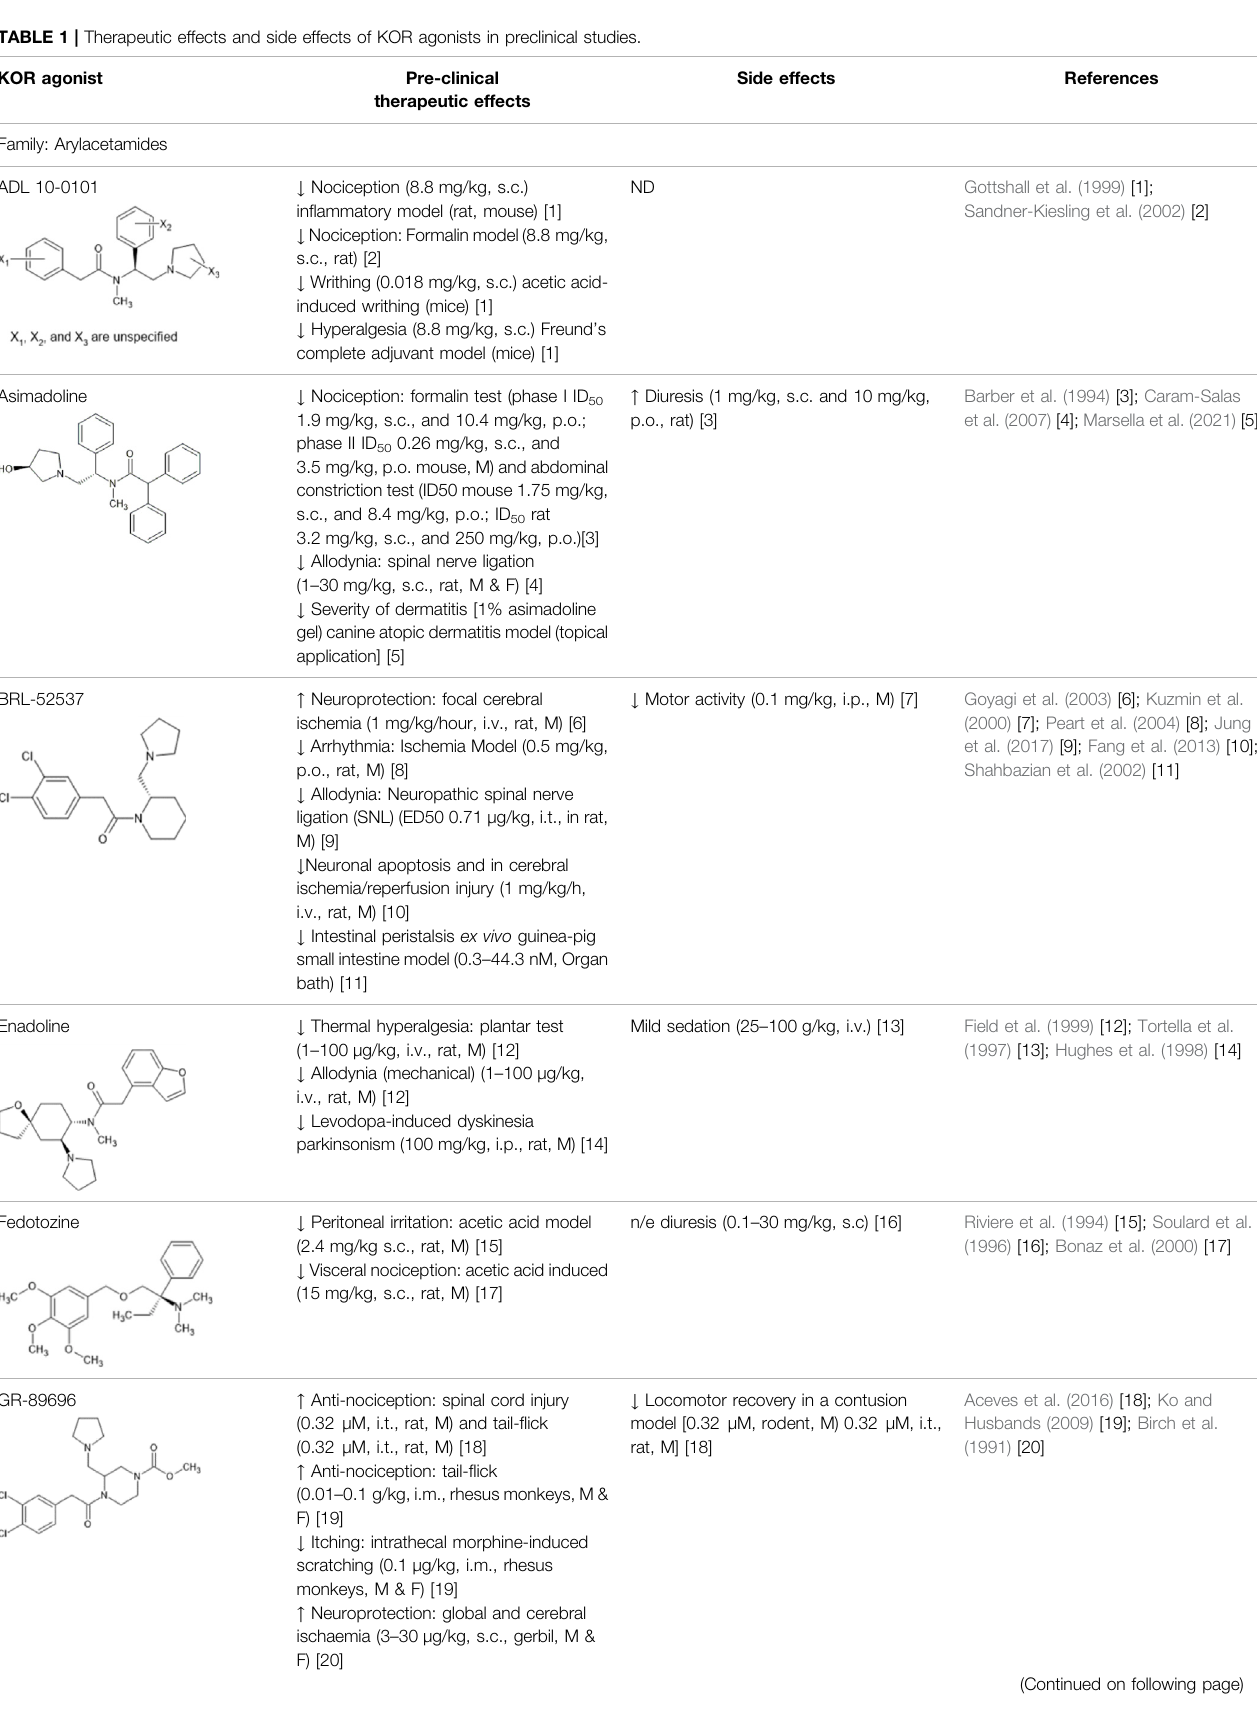
TABLE 1 | Therapeutic effects and side effects of KOR agonists in preclinical studies. KOR